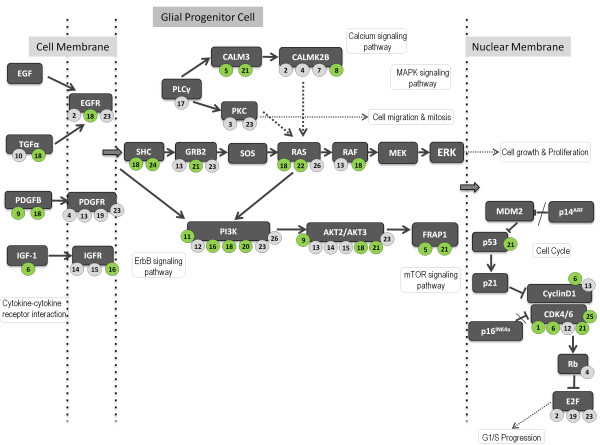
C14 miRNAs target the glioma pathway. The biological process has been drawn by adapting the information from the KEGG pathway. mRNA names are written in dark grey boxes. The miRNAs targeting the corresponding genes are denoted by numbers and written inside circles. The miRNAs that were found to be significantly downregulated in GBM (Figure 2) has been colored in green, the ones not differentially expressed are in grey. The miRNAs are numbered according to their respective positions (5’ – 3’ direction) in the genome: hsa-miR-379 (1), -299-3p (2), -380 (3), -1197 (4), -323-3p (5), -323-5p (6), -323b (7), -758 (8), -329 (9), -543 (10), -495 (11), -654-3p (12), -654-5p (13), -376-a1 (14), -376-a2 (15), -539 (16), -382 (17), -134 (18), -668 (19), -485-3p (20), -485-5p (21), -377 (22), -541 (23), -409-3p (24), -409-5p (25), -412 (26).